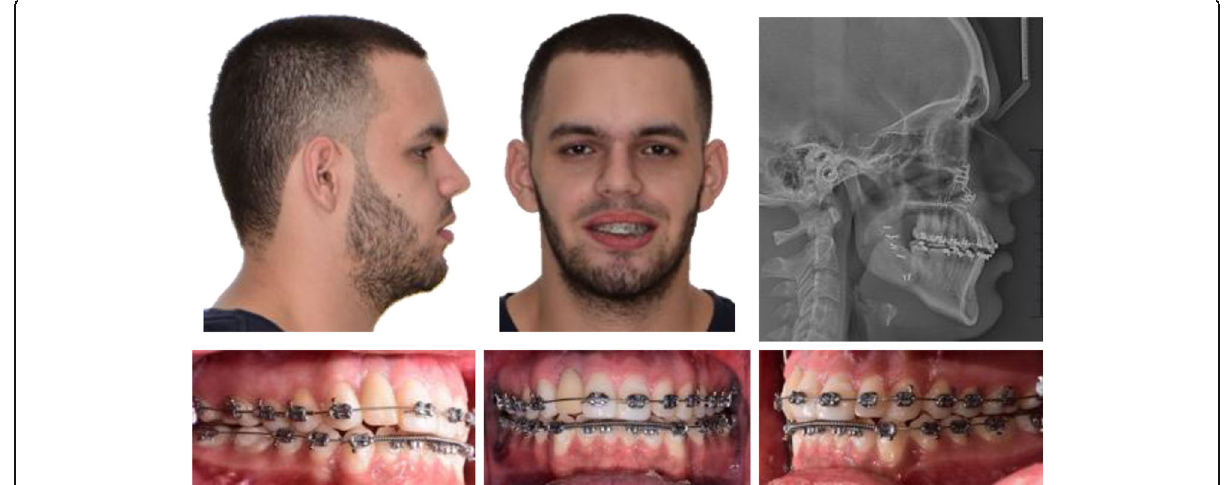
Fig. 2 Extra-oral and intra-oral photos, and lateral cephalic X-ray during treatment